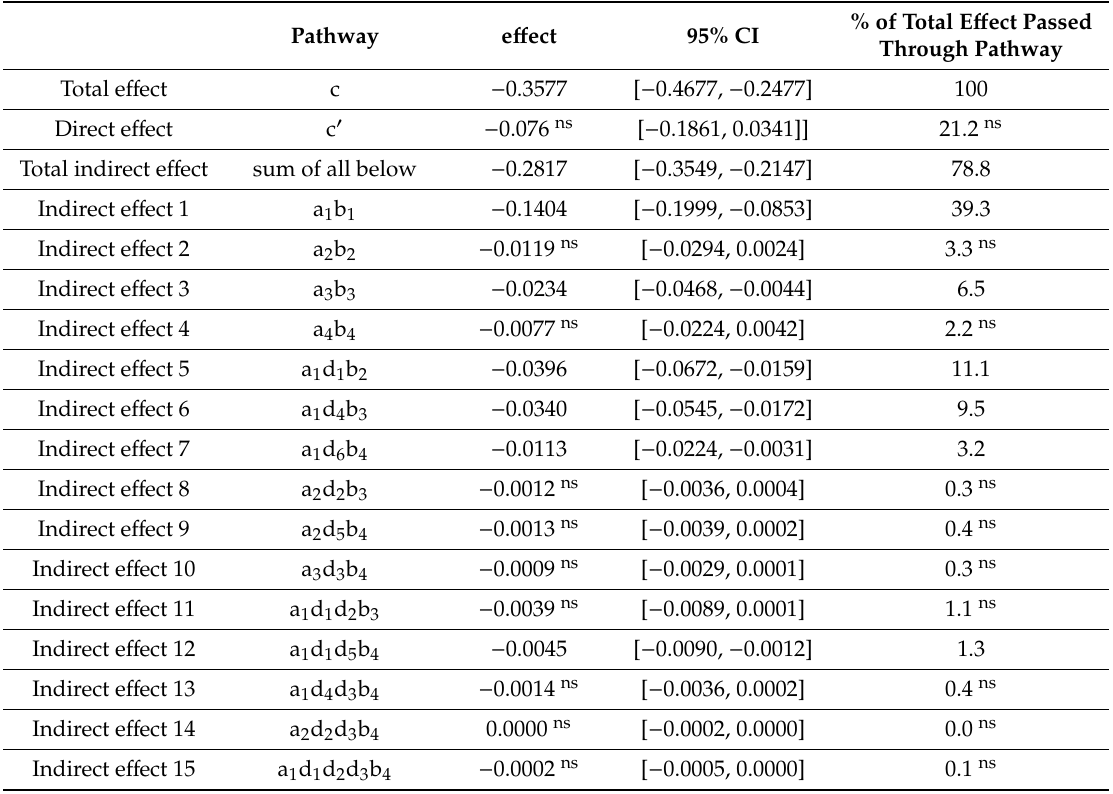
Table A7. Direct and indirect e ff ects for mediating pathways of the relationship between stress in 2012 and work ability in 2017 in females ( n = 857).